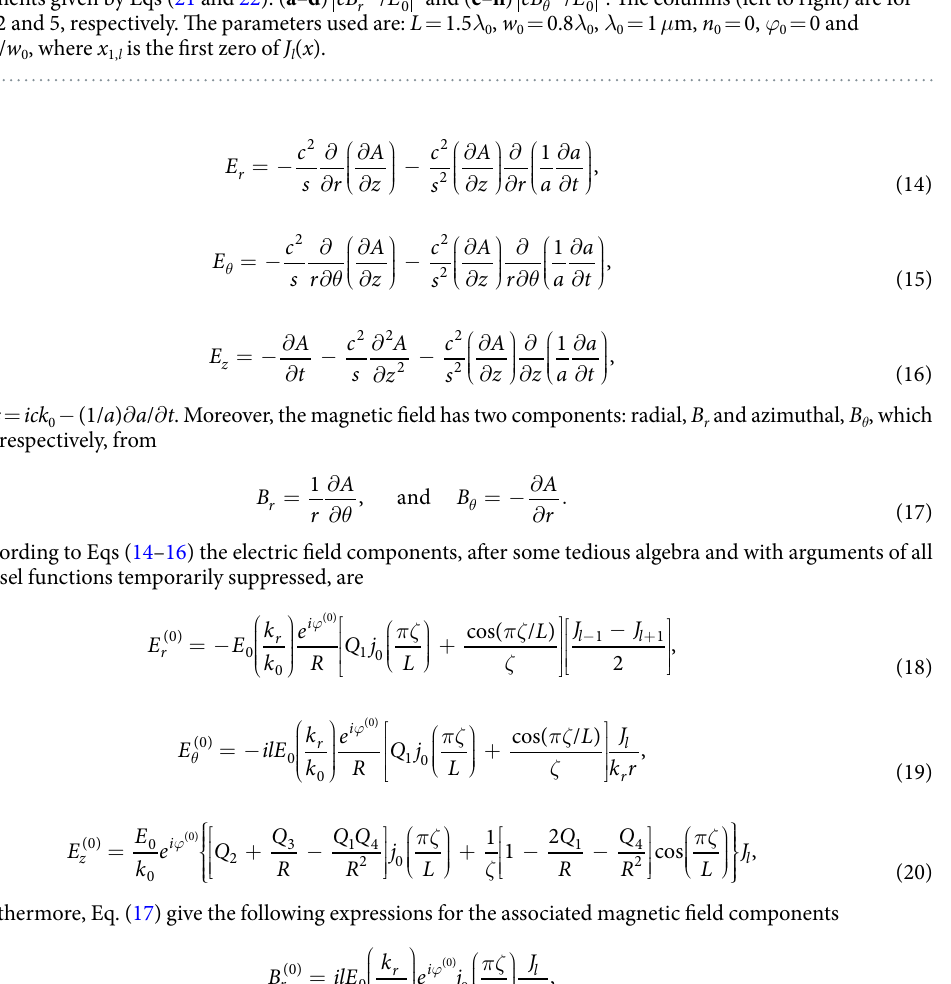
2 2 (0) and ( e – h ) θ cB E / (0) . The columns (left to right) are for r 0 0